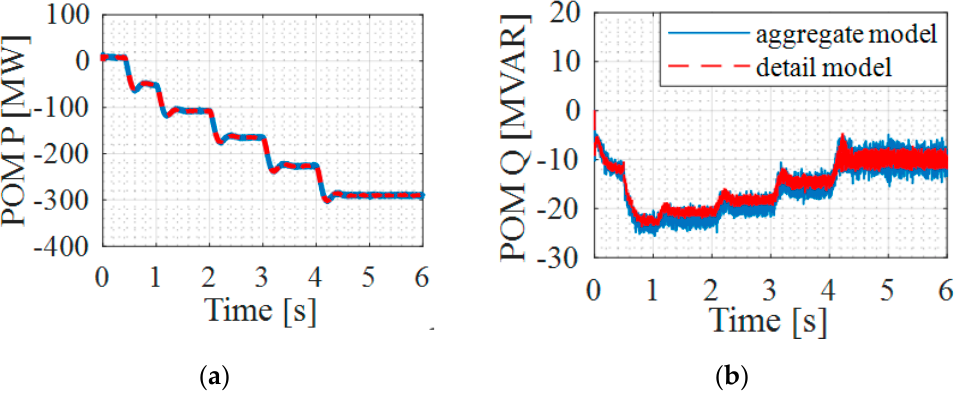
Figure 13. Active and reactive power at the POM for Case 3 using aggregated and detailed models: ( a ) Active power, ( b ) Reactive Power.